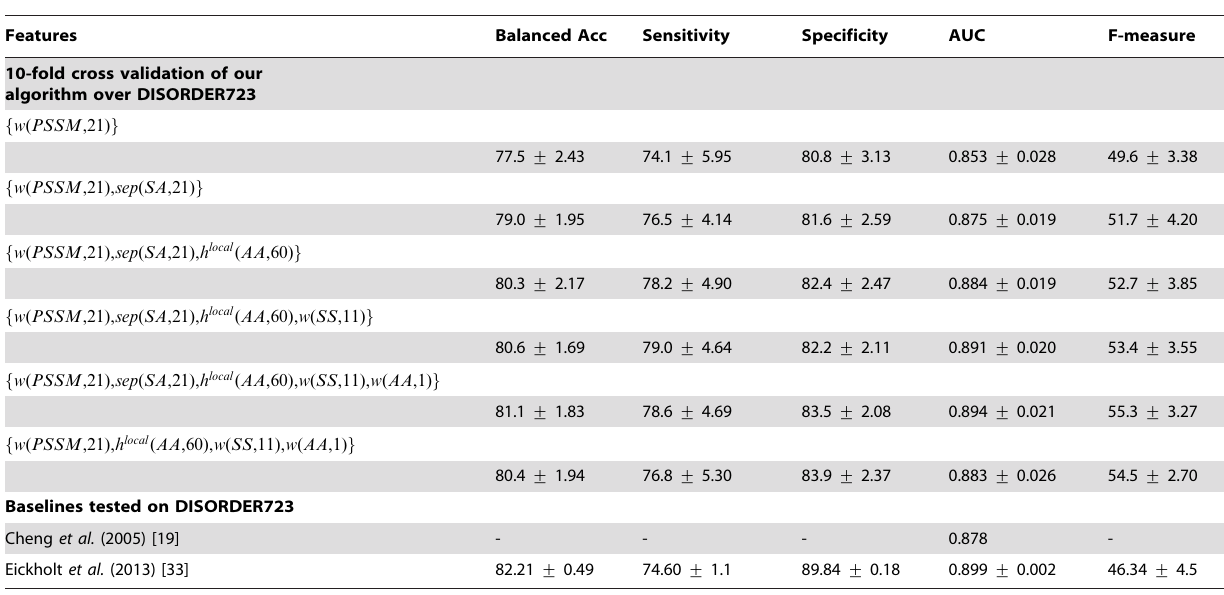
Table 5. Accuracy evaluation on the DISORDER723